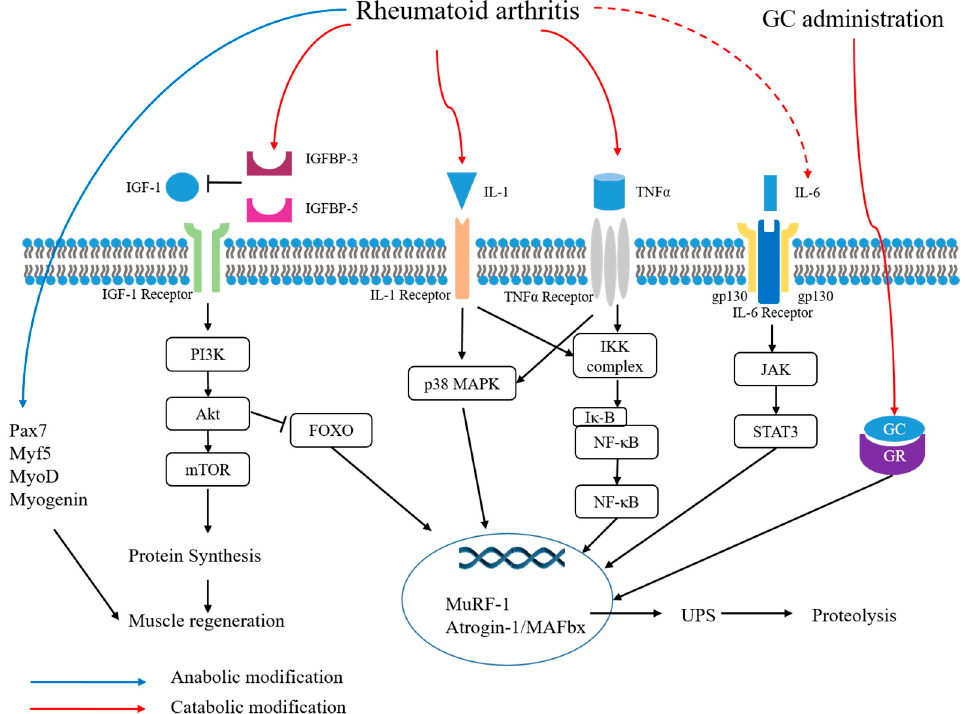
Figure 1. Mechanisms of sarcopenia and metabolic modifications in rheumatoid arthritis. IGF-1, insulin-like growth factor-1; IGFBP, insulin-like growth factor binding protein; IL-1, interleukin-1; TNF- α , tumor necrosis factor- α ; GC, glucocorticoid; GR, glucocorticoid receptor; gp 130, glycoprotein 130; Pax7, paired box 7; PI3K, phosphoinositide 3-kinase; mTOR, mammalian target of rapamycin; MAPK, mitogen-activated protein kinase; IKK, I κ B kinase; I κ B, inhibitor of nuclear factor kappa B; NF- κ B, nuclear factor kappa-light-chain-enhancer of activated B cells; JAK, Janus kinase; STAT3, signal transducer and activator of transcription 3; MuRF-1, muscle RING-finger 1; UPS, ubiquitin